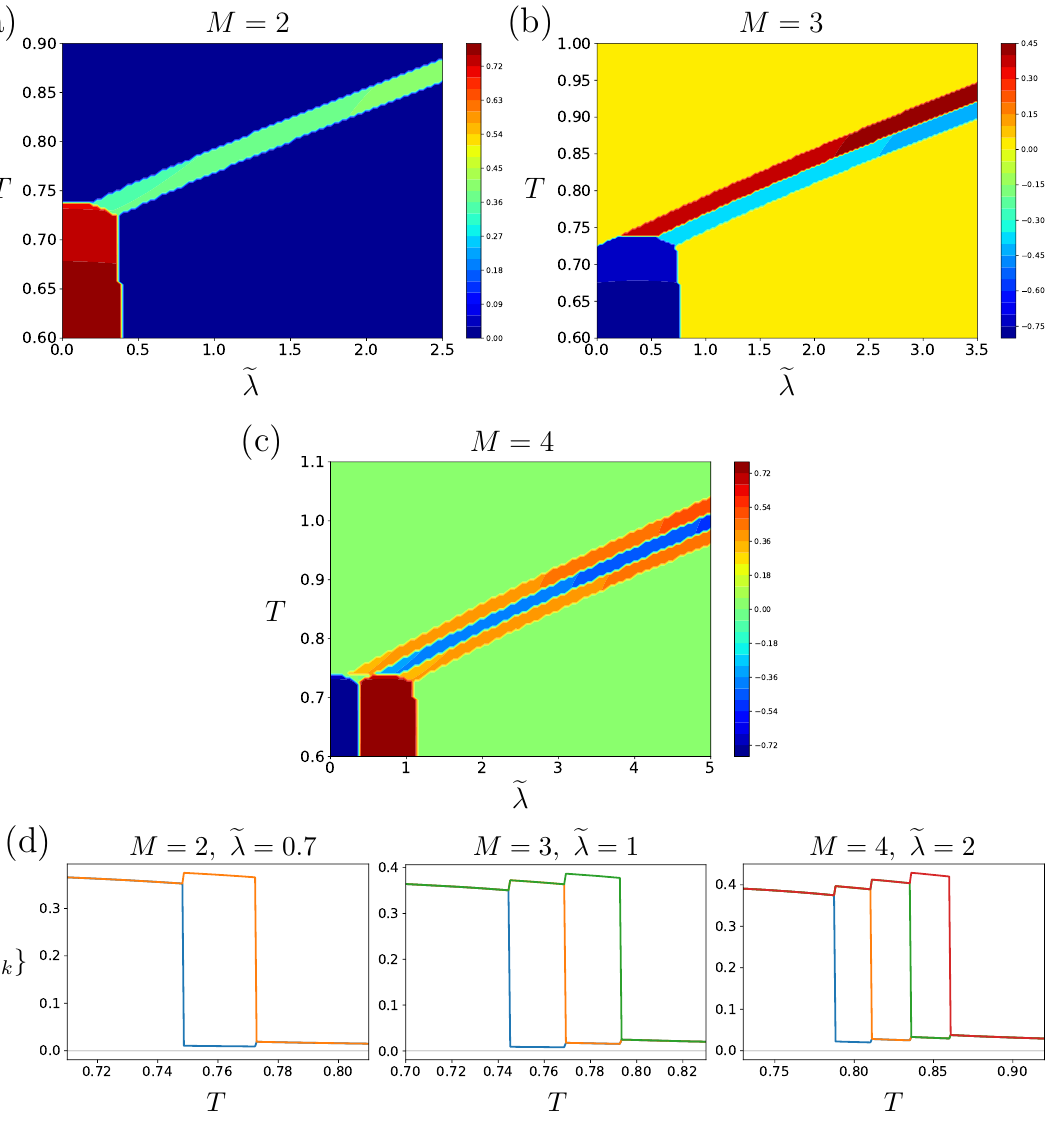
Figure 10 . Figures (a), (b) and (c) show the same plots as in figures 7 and 8 but with phase transitions are first order. (d) The minimum of V eff ( E ) with the temperature rises, the eigenvalues drop sequentially through M first order